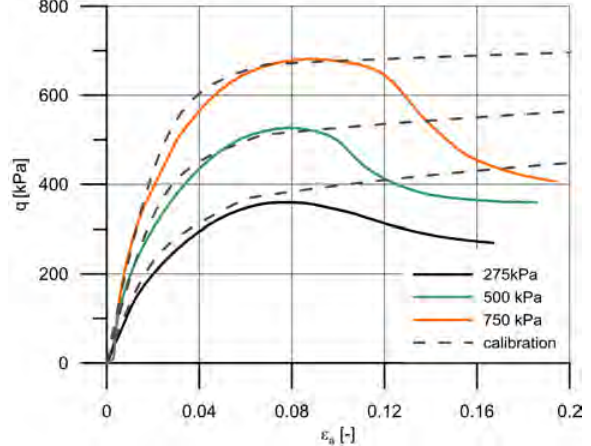
Figure 3. Effective stress